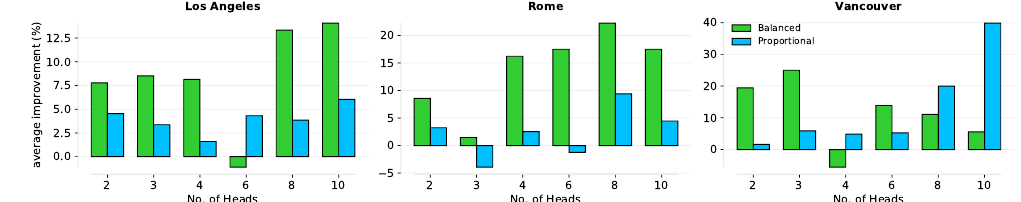
Figure 7. Plots showing the average percentage improvement. Each plot represents the experimental results from each city and the lines denote whether the training nodes were balanced or a proportion of the original class size. We see an improvement of as much as 20% using our sampling